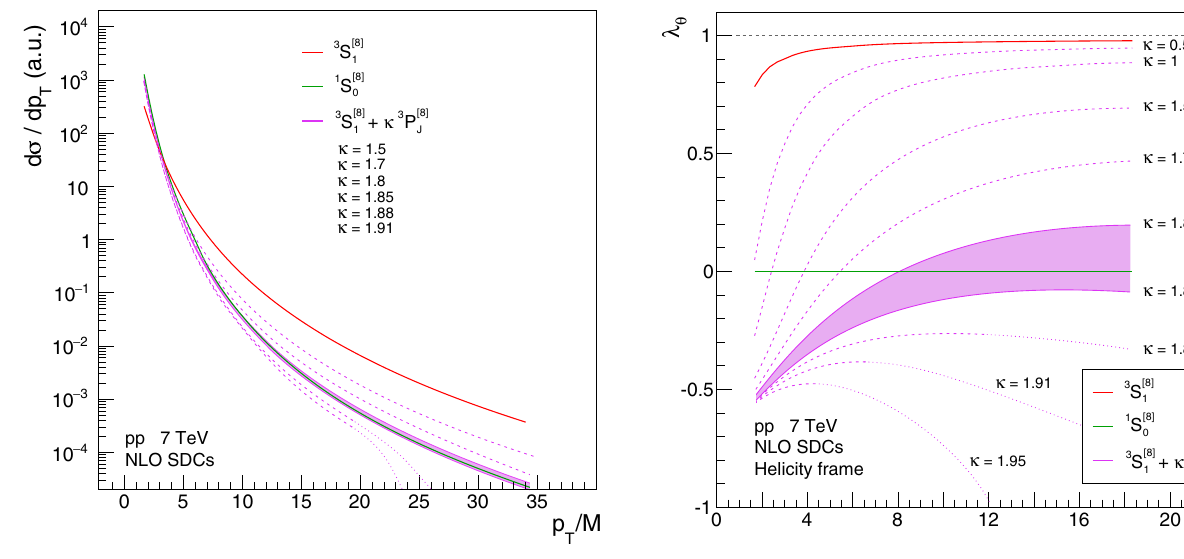
/ M : + κ 3 P [ 8 ] combinations J 1